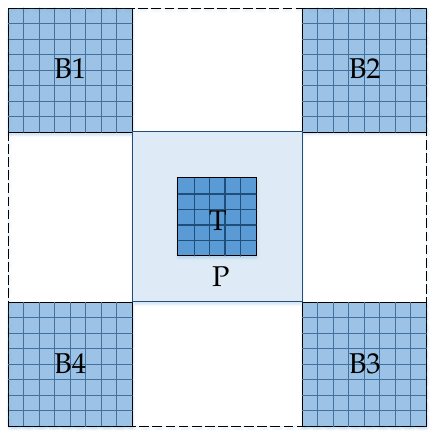
Figure 2. Structure diagram of the local sliding